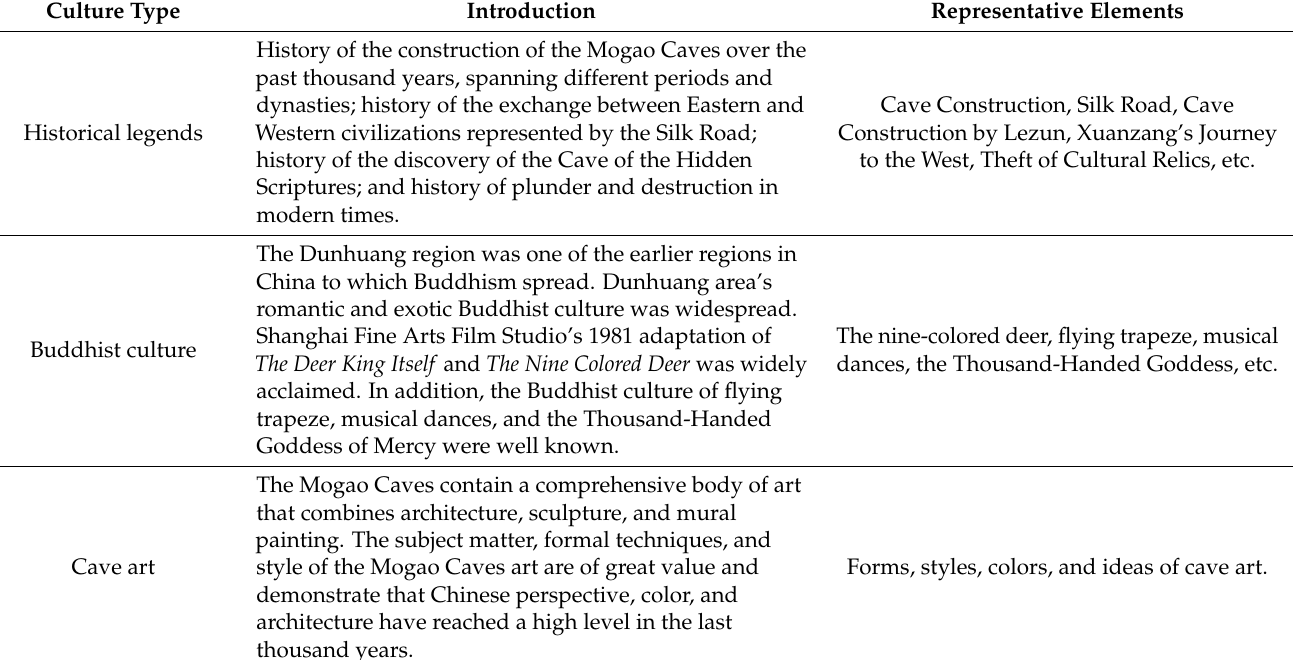
Table 2. Mogao Caves cultural